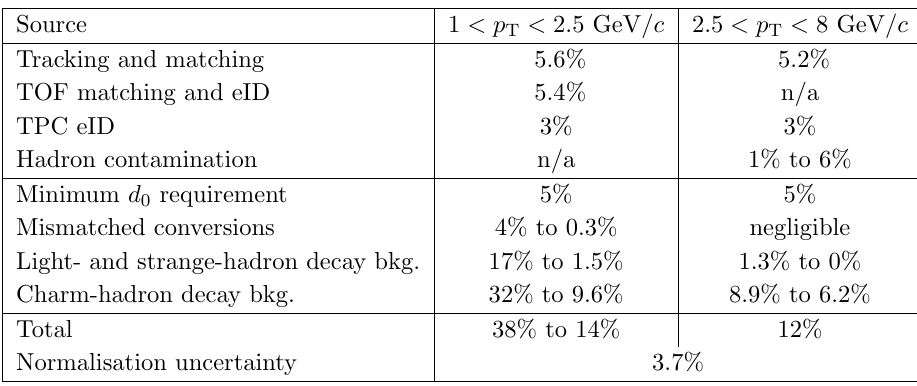
Table 1 . Systematic uncertainties in the p-Pb analysis. The two columns with the di(cid:11)erent mo- mentum intervals correspond to the TPC and TOF and TPC-only eID strategies. Individual sources of systematic uncertainties are p T dependent, which is reported using ranges. The lower and upper values of the interval, respectively, represent the uncertainty at p T = 1 GeV =c ( p T = 2.5 GeV =c ) and p T = 2.5 GeV =c ( p T = 8 GeV =c ) for the TPC and TOF (TPC-only) eID strategy. The lower and upper values of the interval for the hadron contamination are p T = 4 GeV =c and 8 GeV =c